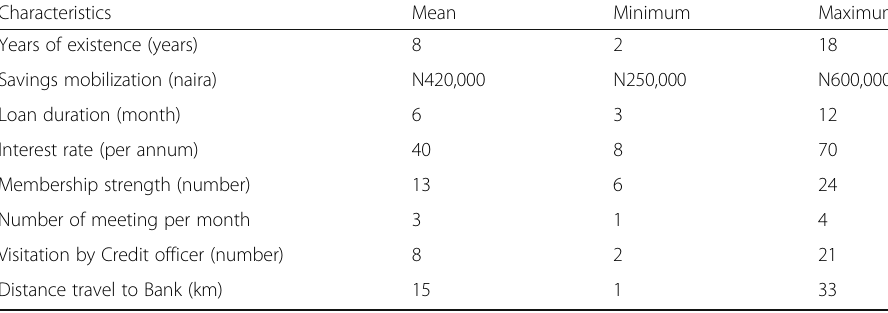
Table 2 Microcredit Finance Groups ’ Mean Characteristics